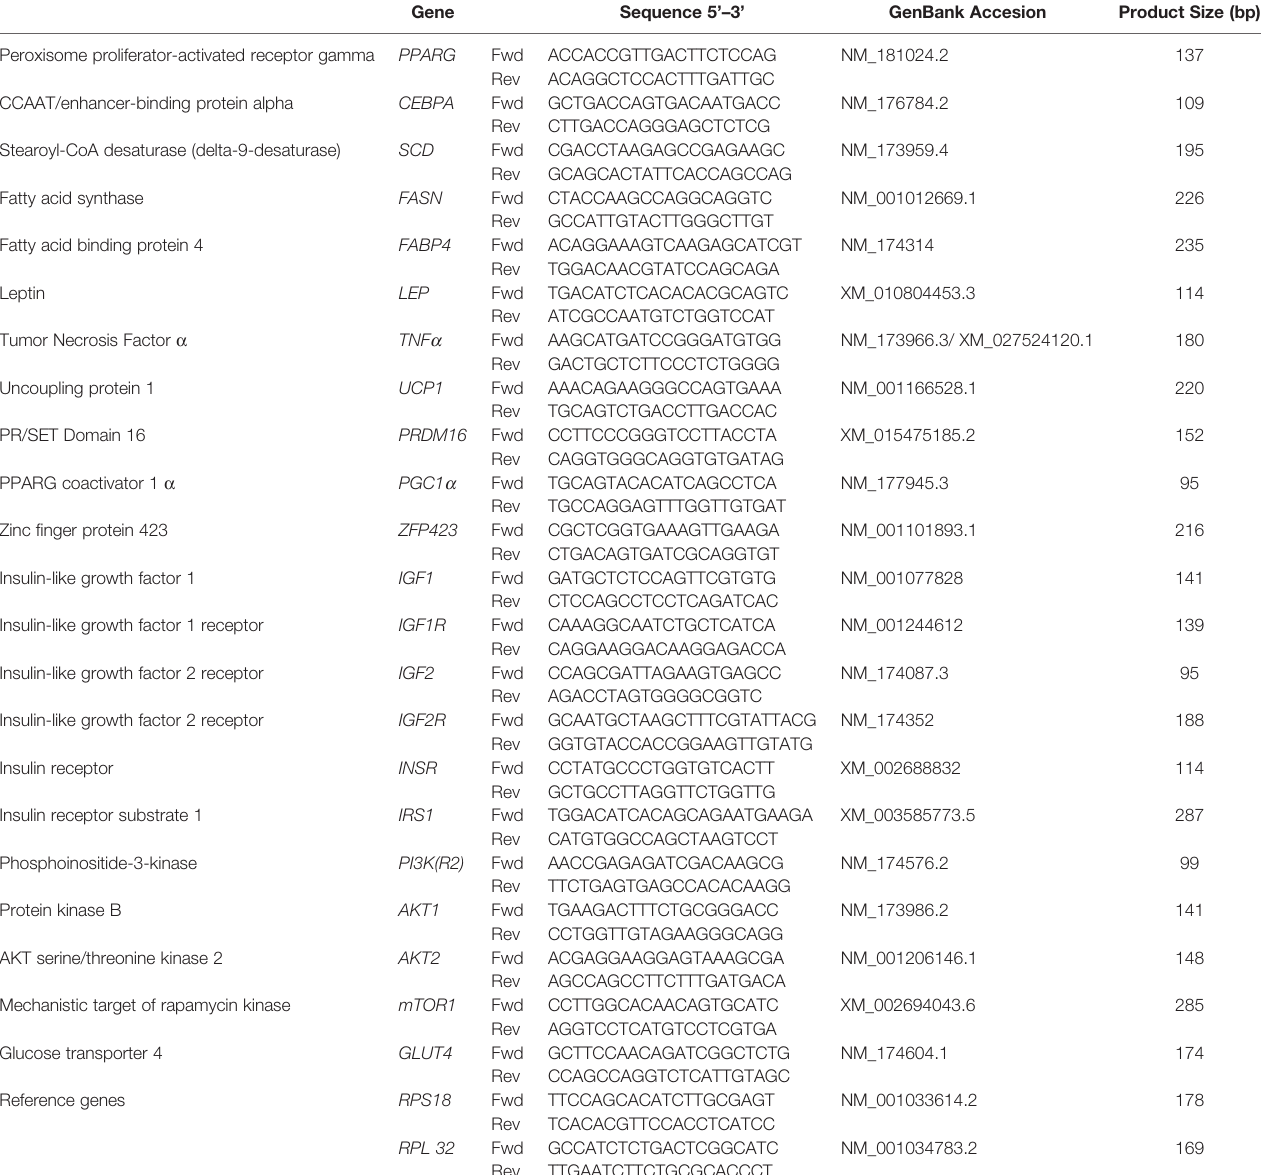
TABLE 1 | Primer sequences for gene expression measured by real-time